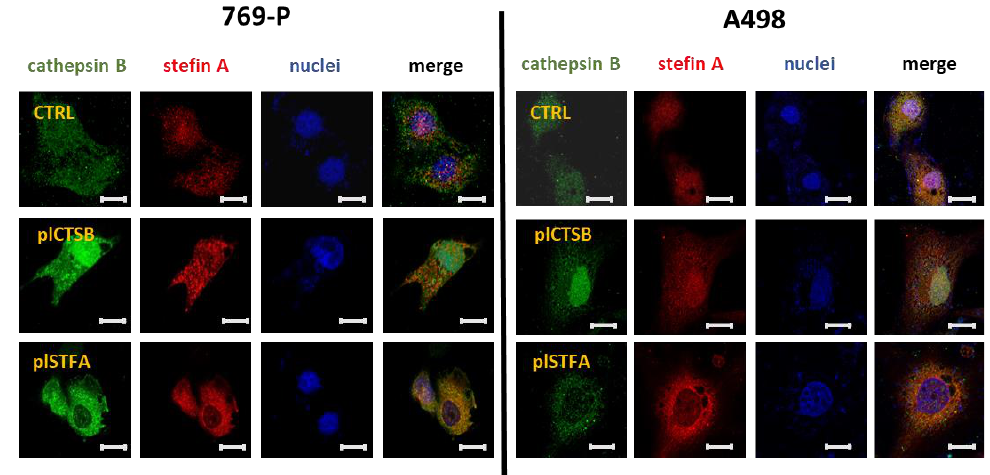
Figure 5. Effect of pl CTSB and pl STFA on StfA and CtsB expression, respectively, in RCC cell lines. After plasmid transfection, CtsB and StfA overexpression was evaluated by immunofluorescence staining. The cell lines were transfected for 72 h, fixed, and stained for CtsB (green) and StfA (red). DAPI staining was used to label the nucleus (blue). In both the cell lines, the overexpression of CtsB induced an increase in the cellular content of Stfa and vice versa. Representative images from three independent experiments are shown. Scale bar: 10 µm. Consistently, CtsB and StfA silencing negatively affected cell proliferation (769-P: sh CTSB , p = 0.016; sh STFA , p = 0.003; A498: sh CTSB , p = 0.009; sh STFA, p = 0.0022).